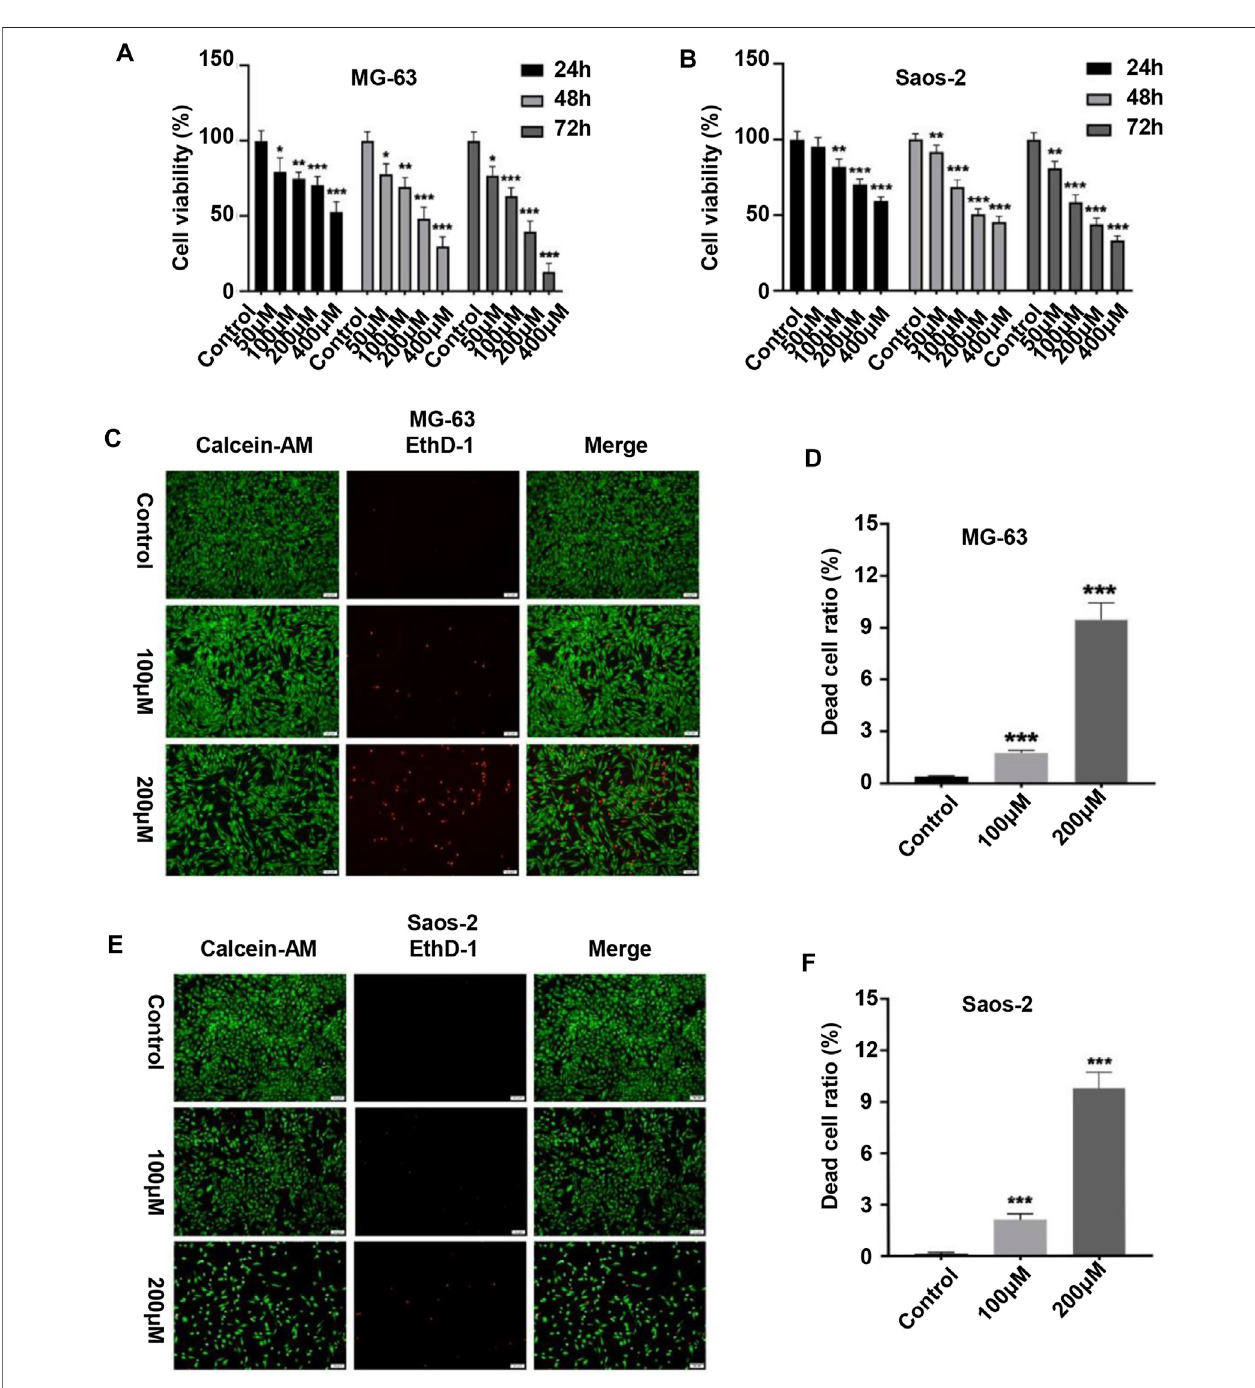
FIGURE 1 | Peiminine inhibited the proliferation of osteosarcoma cells. (A,B) Human osteosarcoma MG-63 and Saos-2 cells were treated with peiminine (0 – 400 μ M) for 24, 48, or 72 h, following which cell viability was assessed by cell counting kit-8 (CCK-8) assay. (C,E) Peiminine signi fi cantly reduced the number of live cells (green fl uorescence) and increased the number of dead cells (red fl uorescence) in a concentration-dependent manner after 48 h of treatment as determined under an inverted fl uorescence microscope. Scale bar (cid:2) 100 μ m. (D,F) Quantitative analysis of the live and dead assays ( n (cid:2) 3). * p < 0.05, ** p < 0.01, *** p < 0.001.